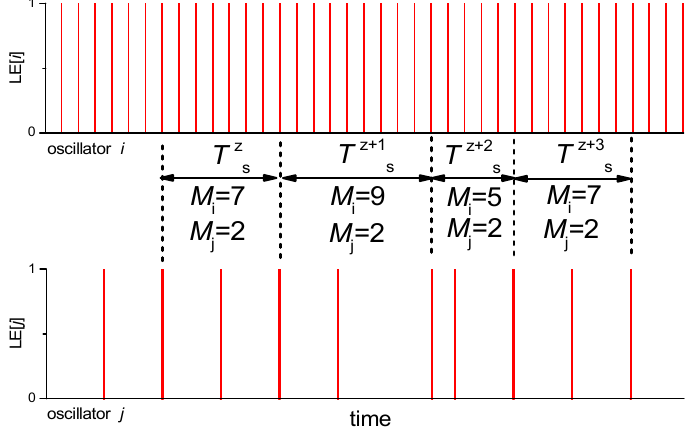
Figure 4. Arrays LE[ i ][ t ] and LE[ j ][ t ] for two oscillators with non-constant period of synchronization T z s .